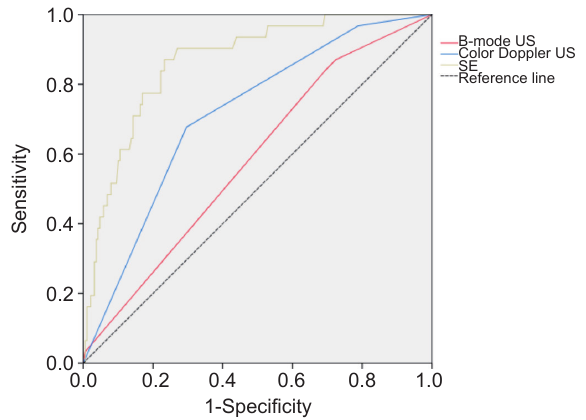
Figure 2 Receiver operating characteristic curves for B-mode US, Strain Elastography and color Doppler US. The area under the curve (AUC) for B-mode US was 0.584 (95% confidence interval [CI]: 0.481, 0.687); 0.865 (95% CI: 0.802, 0.928) ( P < 0.001) for strain elastography, and 0.713 (95% CI: 0.622, 0.805) ( P = 0.069) for color Doppler US.